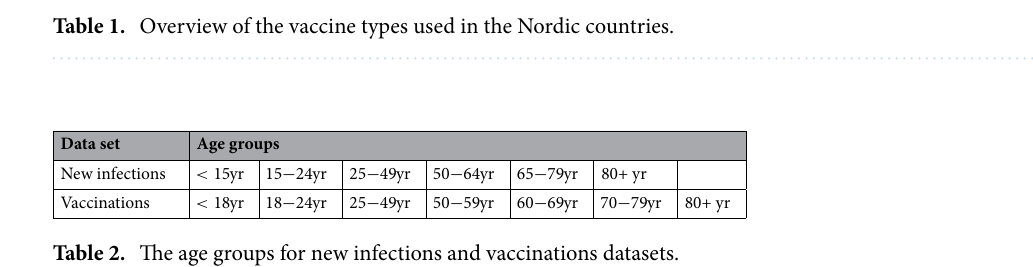
Table 2. The age groups for new infections and vaccinations datasets.